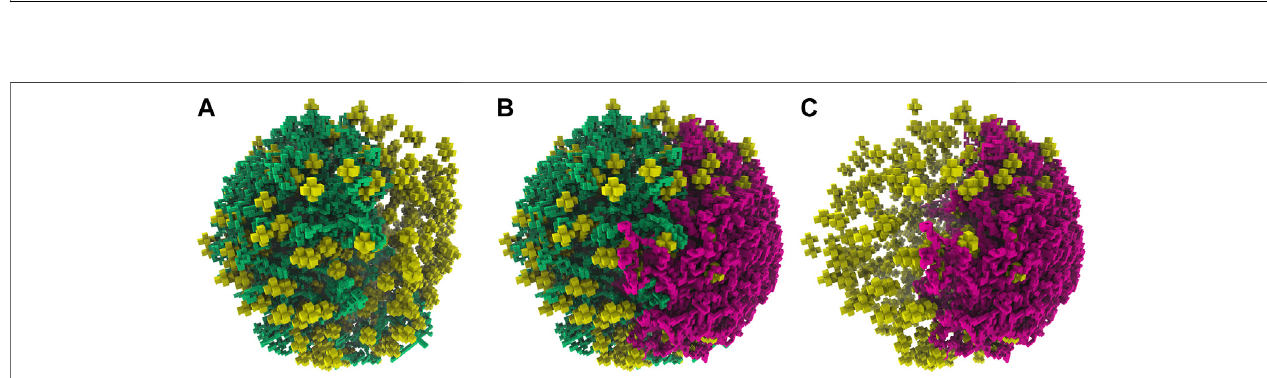
FIGURE 9 | (A) — Relative frequencies of chromosome site monomer occupancies in the small cell from 150 con fi gurations with no looping interactions. (B) — Distribution of connected-component sizes for different monomer occupancy thresholds for the small cell from 150 con fi gurations with no looping interactions.